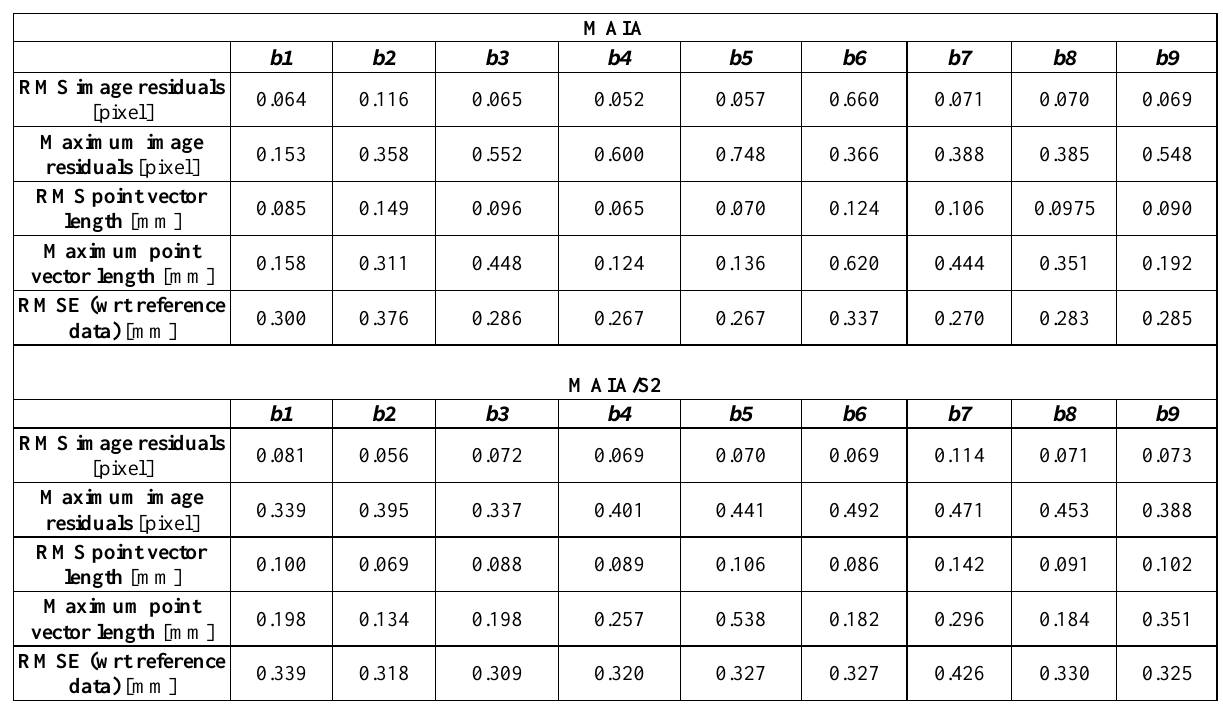
Table 3. Internal and external assessment of the self-calibrating bundle adjustment for two MAIA